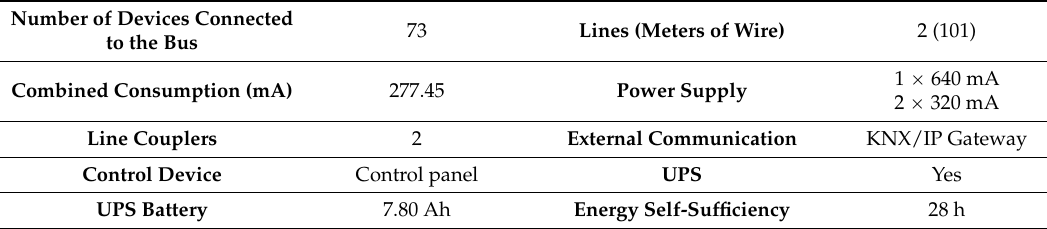
Table 7. General features of advanced home automation